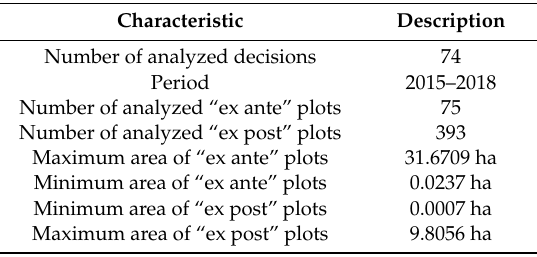
Table 2. Description of analyzed